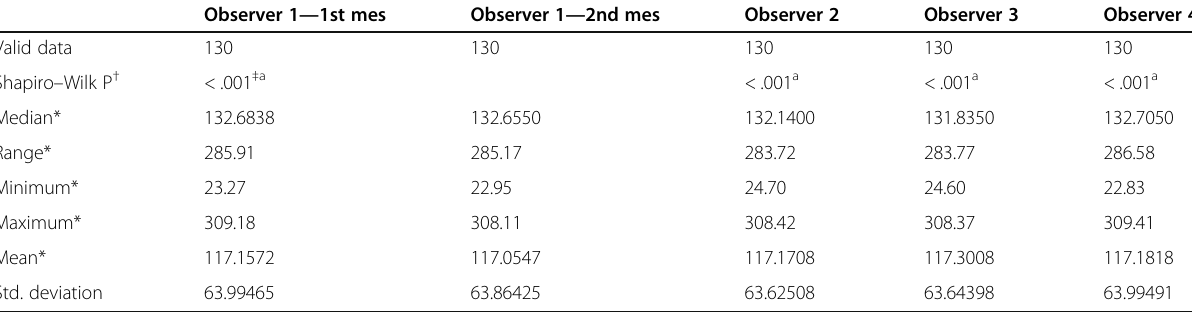
Table 1 Descriptive statistics of the image analysis procedure for all observers